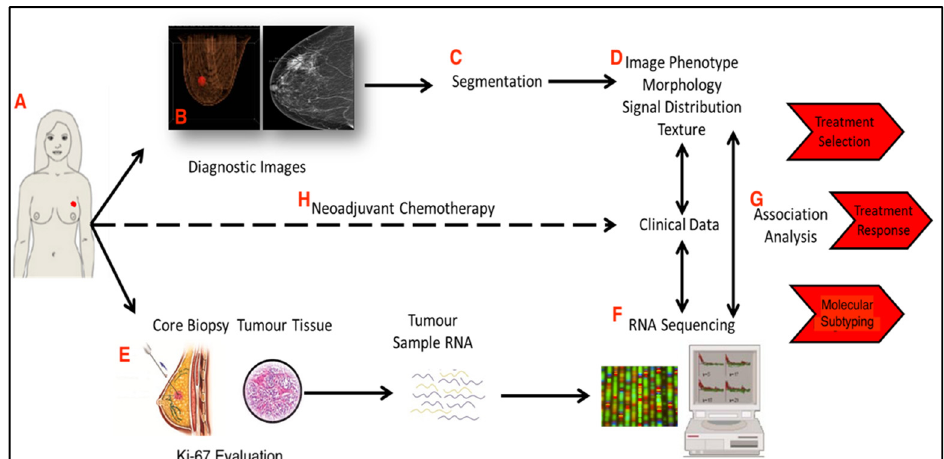
Figure 3. This figure depicts the systematic stages required to augment therapeutic decision making in relation to neoadjuvant chemotherapy in conjunction with Ki-67 evaluation using radiogenomic tumour appraisal. These stages begin at ( A ) initial presentation and are conducted through to combined analysis of clinicopathological, radiomic, and genomic data in order to personalise oncological care: ( B ) represents diagnostic preoperative imaging which is ( C ) segmented before quantitative data are retrieved from the acquired preoperative imaging ( D ). Histopathological data obtained from core tissue biopsy remain the ‘gold standard’ method of diagnosing malignancy ( E ); however, ( F ) molecular profiling of tumour tissue through RNA sequencing may be included in genomic data. Radiogenomics looks to collate clinical, radiomic, and genomic parameters through association analysis in order to better inform treatment selection, predict responses to therapies, and substratify disease subtypes and their associated prognoses ( G ). This schema illustrates the value of radiogenomics as an adjunct to enhance predicting the response to neoadjuvant chemotherapy ( H ) in the setting of breast carcinoma, with a focus upon utilising Ki-67 expression to aid this process.